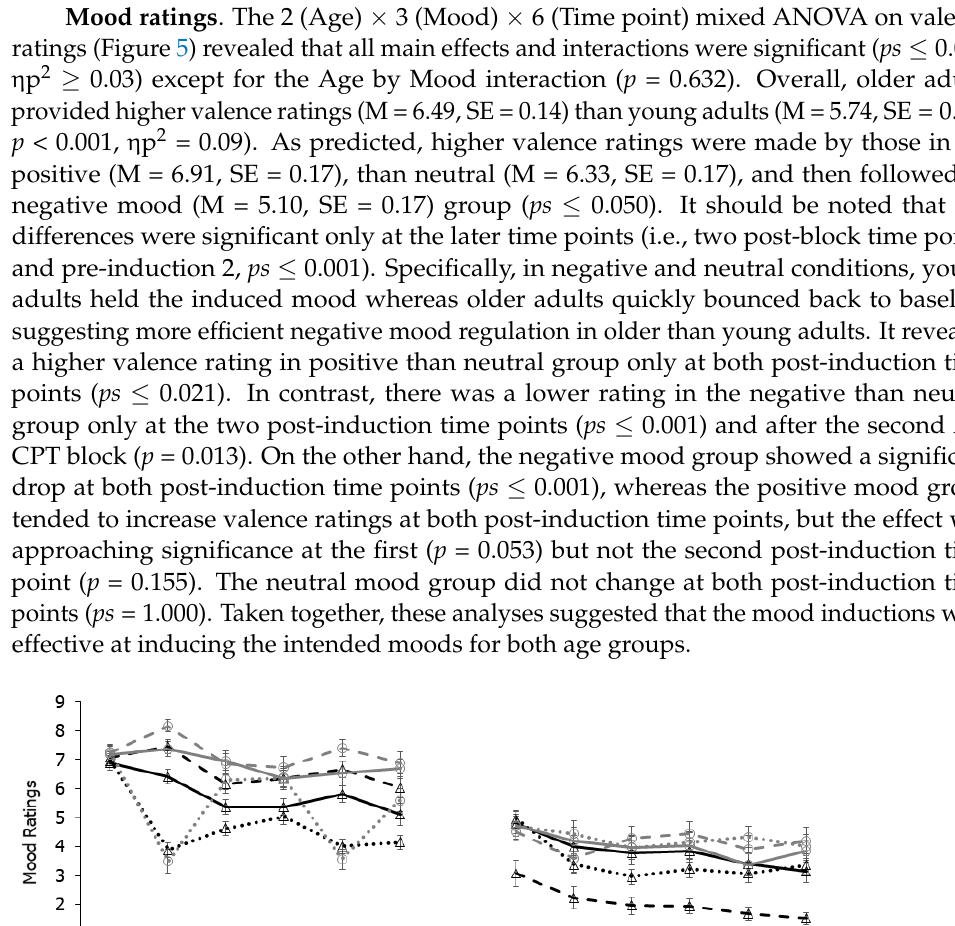
Overall procedure . The procedure was identical to that of Experiment 1 except for the addi- tion of a positive mood induction condition in which participants viewed positive images against calm/peaceful classical music background during the mood induction.